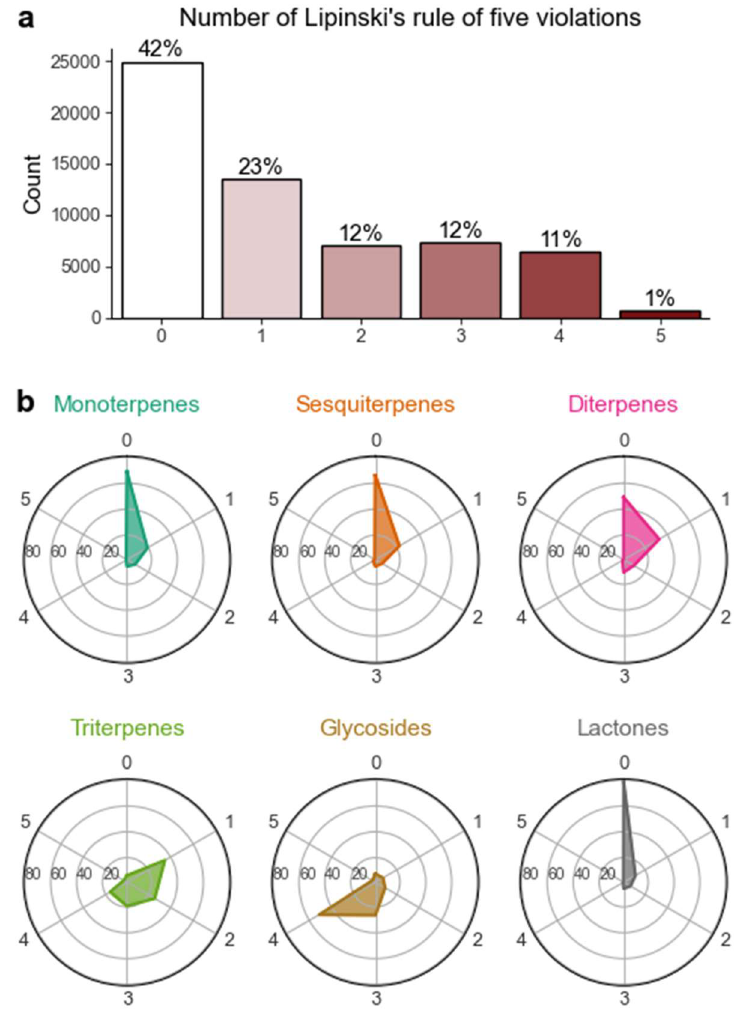
Figure 7. ( a ) Number of violations of Lipinski’s rule of five in the terpene chemical space, for all terpenes, and ( b ) across distinct subclasses; outer values correspond to the number of violations and inner values the percentage of a given number of violations.